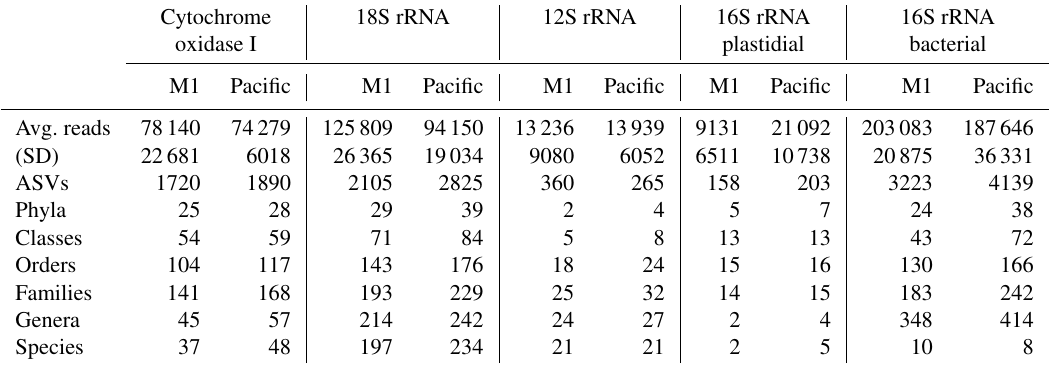
Table 1. DNA sequencing statistics. The 16 total samples were divided between 8 M1 (mesocosm) and 8 Pacific samples, with “Avg. reads” and “Stdev” reflecting the average and standard deviation (respectively) of the number of reads per sample. All other values represent the total sum across all samples. Across all five datasets, the Pacific samples consistently show a higher level of alpha diversity at all levels of